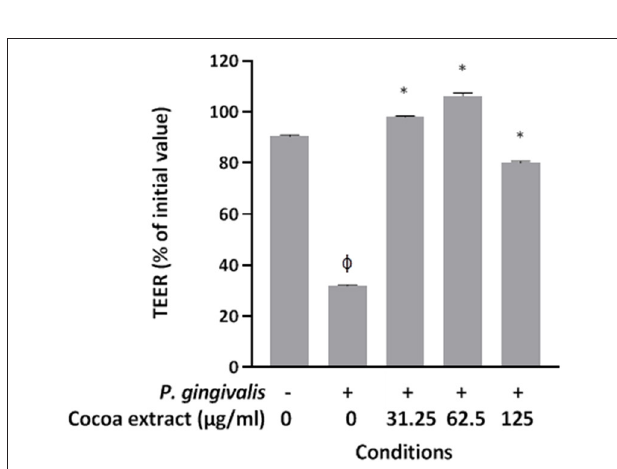
FIGURE 7 | Effect of the cocoa extract on P. gingivalis -mediated loss of oral keratinocyte barrier function. Bacteria were used at MOI of 10 4 , and the barrier function of the keratinocyte model was assessed by monitoring the transepithelial electrical resistance (TEER) values at time 0 and after a 48-h incubation (37 ◦ C/5% CO 2 ) using an ohmmeter. A relative value of 100% was assigned to the TEER recorded at time 0. Results are expressed as the means ± SD of triplicate assays from three independent experiments. ϕ , significant decrease ( p < 0.001) compared to unstimulated control cells. *, significant increase ( p < 0.001) compared to P. gingivalis -stimulated cells not treated with the cocoa